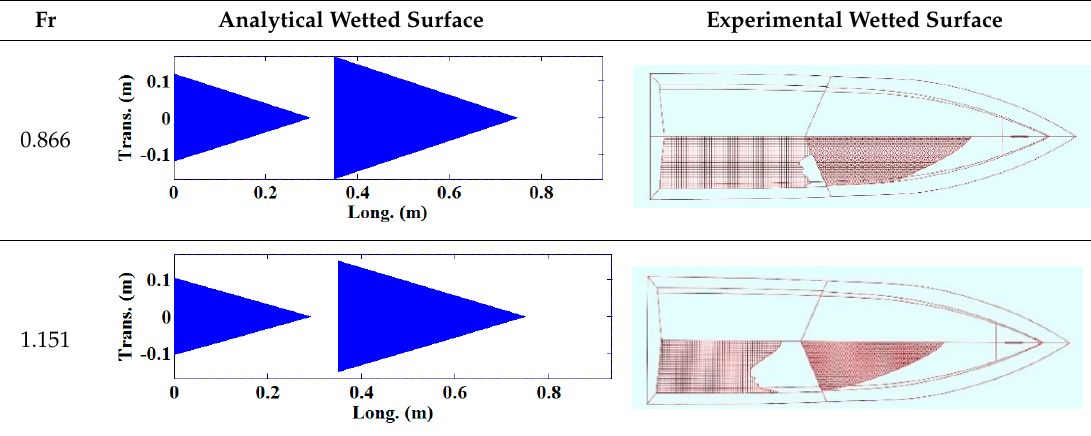
Table 4. The detailed view of the dynamic wetted surface for the experimental test and analytical method.